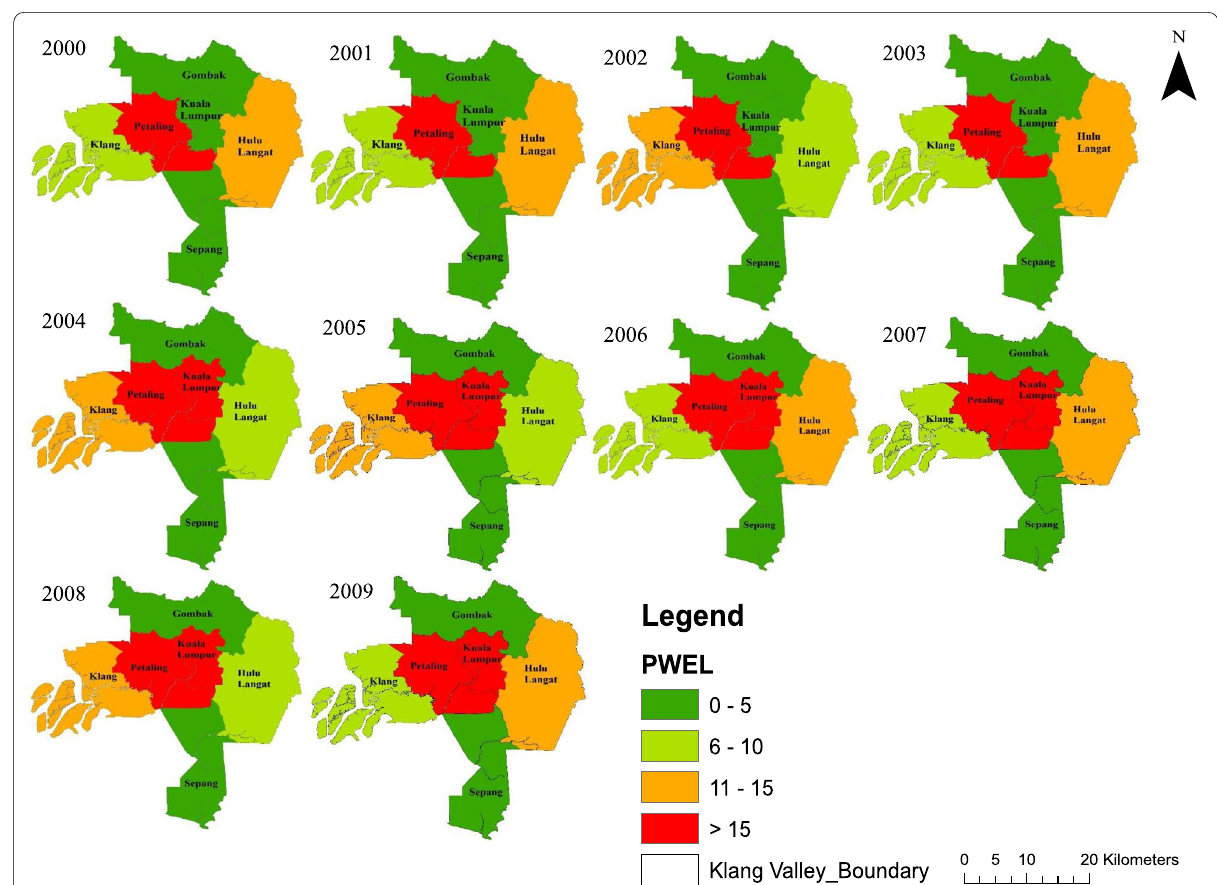
Fig. 5 PWEL’s spatial distribution for PM 10 concentrations (µg/m 3 ) at four districts in the Klang Valley: Klang district represented Klang DOE monitoring station, Petaling district (Shah Alam and Petaling Jaya stations), Kuala Lumpur district (Cheras station) and Hulu Langat district (Kajang station) from 2000 to 2009. Note Gombak and Sepang districts are not